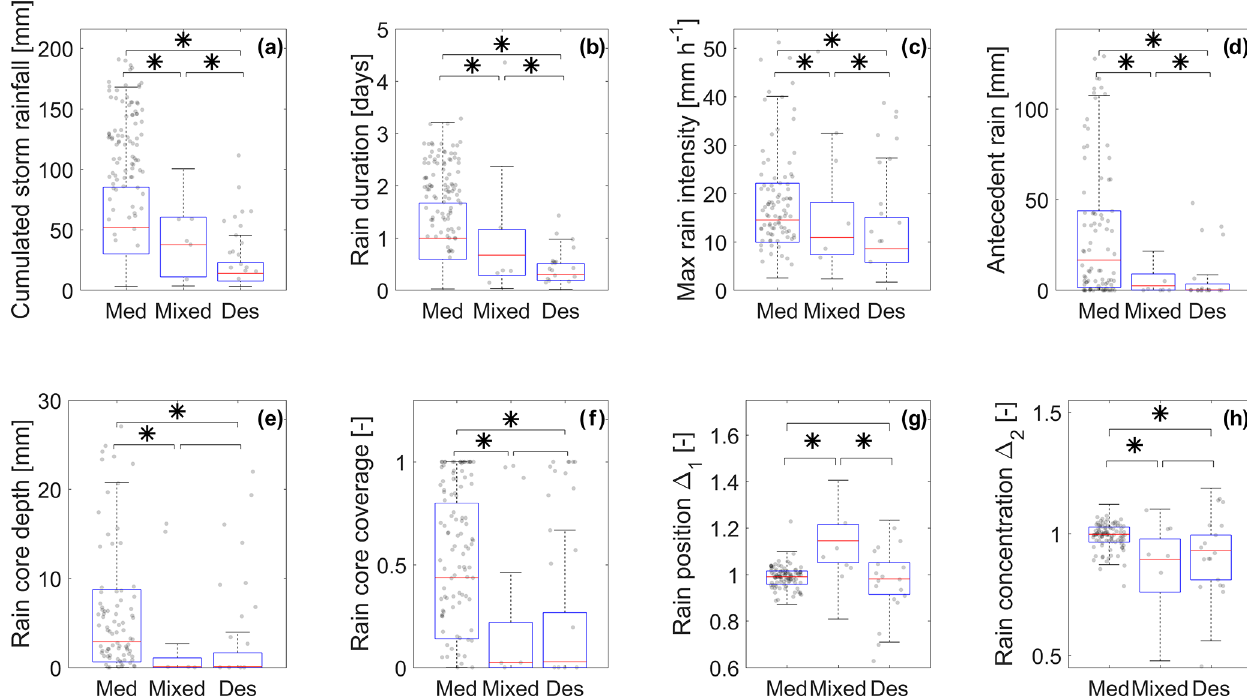
Figure 4. Boxplots showing the distribution of event rainfall properties in the three climate classes. The asterisk describes distributions with a statistically different median (Wilcoxon test, p value < 0 . 05). Black dots represent floods with more than 5 years of return period; outliers are not